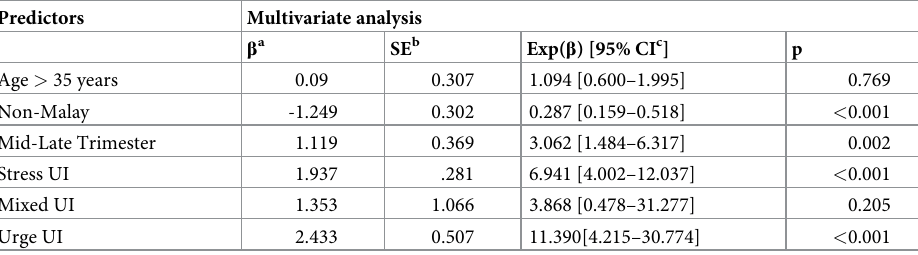
Table 3. Multivariate analysis of the significant predictors of QoL among pregnant women.